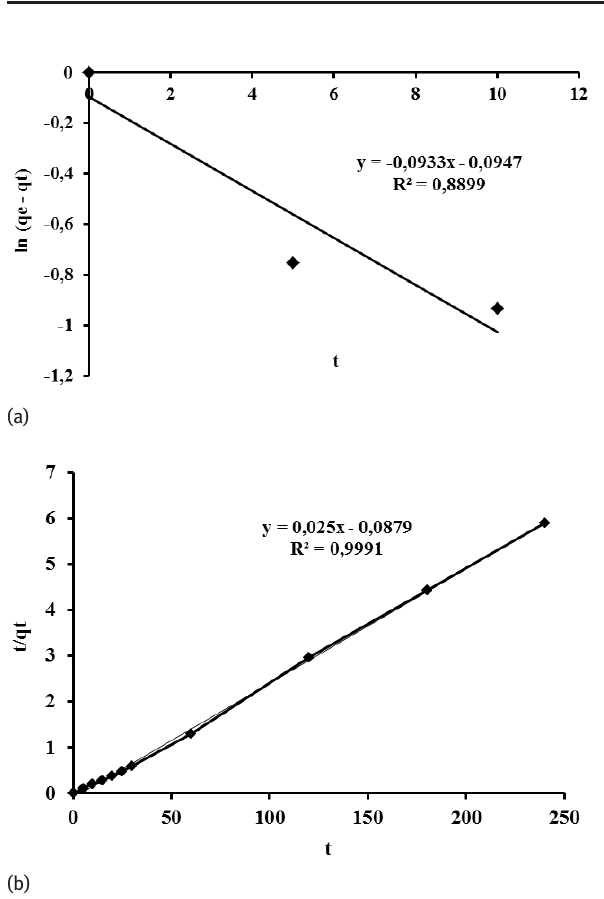
Figure 7: Kinetics adsorption model (a) pseudo first order, (b) pseudo-second order.